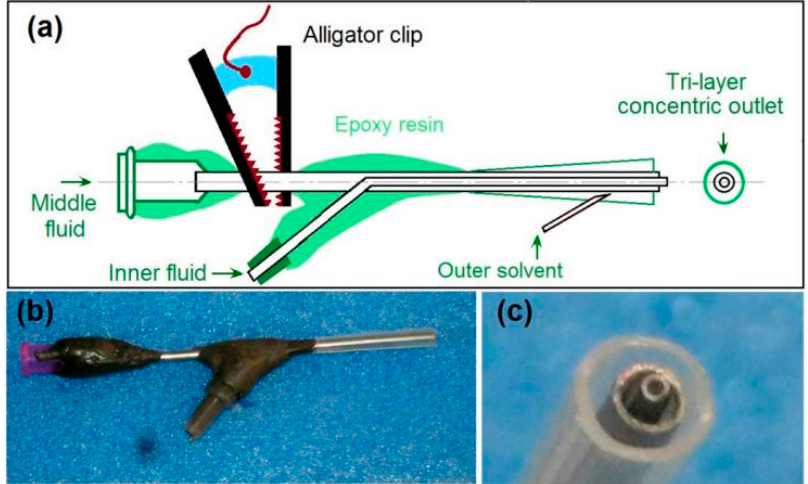
Figure 2. The homemade spinneret for implementing the modified tri-axial electrospinning: ( a ) the details about the inner structures of spinneret and its components; ( b ) a digital photo of the whole spinneret; ( c ) a digital photo of the tri-layer concentric outlet for leading the outer–middle–inner spinning solutions.